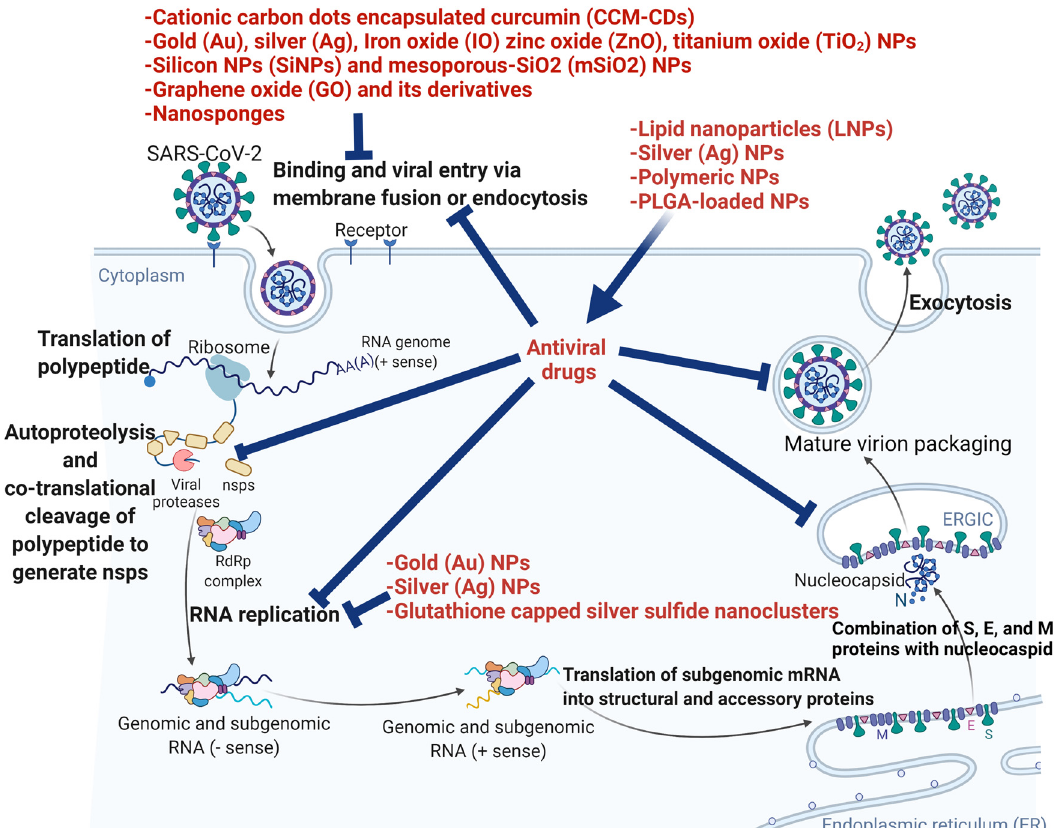
Figure 7: The life cycle of SARS - CoV - 2 and its replication within the host cell and the therapeutic points of intervention. Viral attachment and entry through endocytosis may represent the most important point for blocking. Nanoparticles could target SARS - CoV - 2 cellular entry, viral replication, and viral packaging and assembling besides their capability to act as carriers for antiviral delivery in host